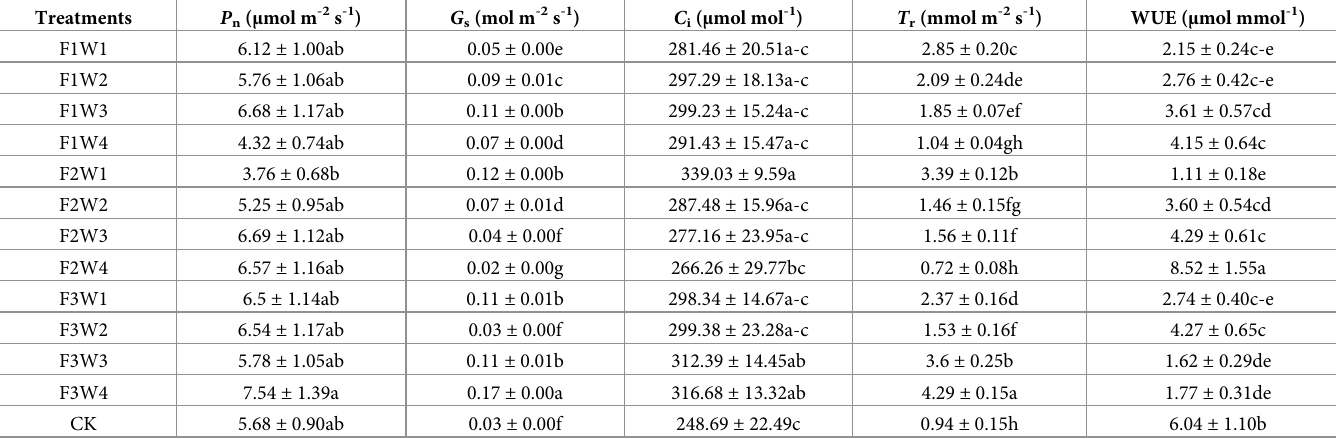
Table 2. Effects of water and fertilizer coupling on blueberry photosynthetic characteristics.